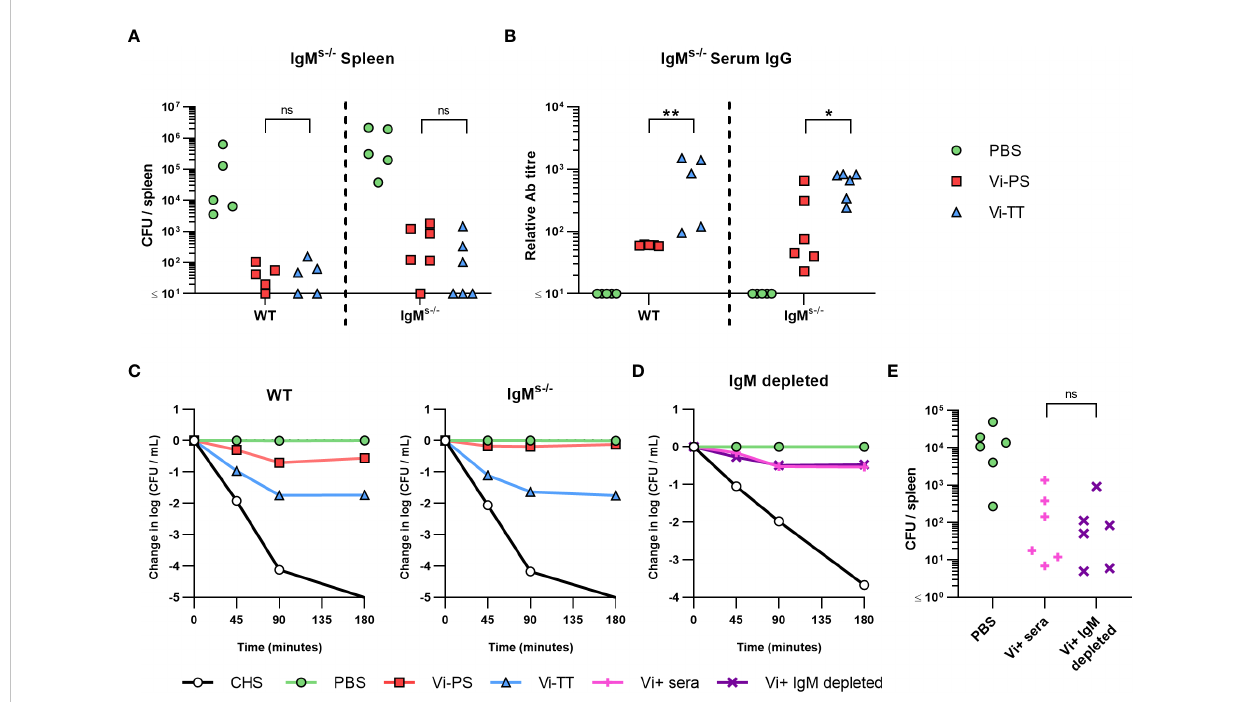
FIGURE 4 Anti-Vi IgG induced by Vi vaccines is suf fi cient to impair infection. (A) Colony forming units (CFU) in the spleen of C57Bl/6 (WT) and IgM s-/- mice immunized i.p with 2 µg Vi-PS, Vi-TT or PBS, then infected for 24 hours with 1x10 5 CFU Vi+ S. Typhimurium TH177 14 days later. Data pooled from 2 experiments with n = 2 or 4 mice/group. (B) Serum anti-Vi IgG titres of WT and IgM s-/- mice were assessed by ELISA. (C) Serum bactericidal activity of WT and IgM s-/- sera was measured against TH177, represented as mean change from the starting LogCFU/mL bacterial dose, normalised to the negative control values at each timepoint. Error bars represent SEM. (D) Pooled WT hyperimmune anti-Vi sera were depleted of IgM using anti- mouse IgM coated Sepharose beads, and serum bactericidal activity against TH177 measured by SBA. Representative of individual serum samples, showing change from the starting LogCFU/mL bacterial dose, normalised to the negative control values at each timepoint. Complete human serum (CHS) was used as a positive control. (E) Spleen CFU counts of WT mice infected for 24 hours with 1x10 5 CFU TH177 opsonised with IgM depleted serum. Data pooled from 2 experiments with n= 2 or 4 mice/group. *p<0.05, **p<0.01 and ns = non-signi fi cant by Mann-Whitney U test between individual groups